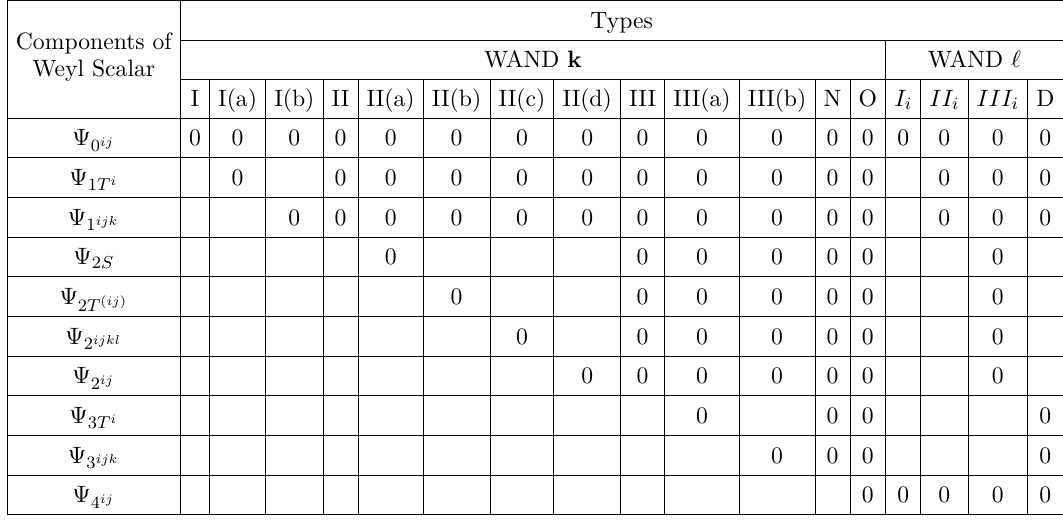
Table 2 . General algebraic classifications of shearfree, twistless spacetimes with necessary vanishing Weyl scalars for both WANDs k and ‘